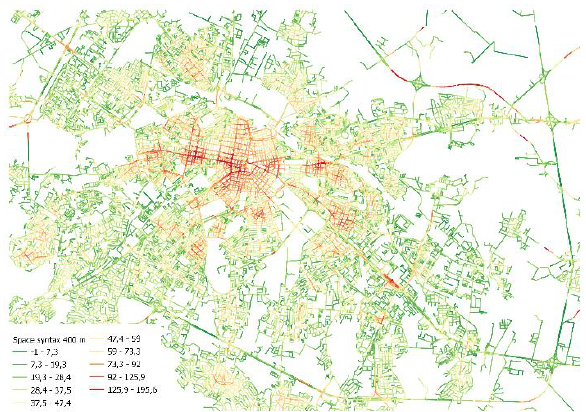
Figure 15. Spatial Syntax Integration Analysis with Search radius of 400